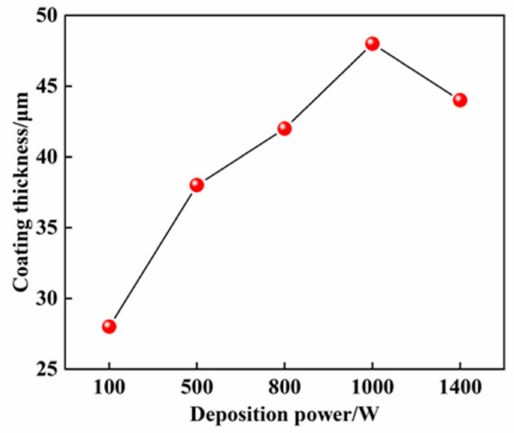
Figure 11. Effect of deposition power on the thickness of coating.